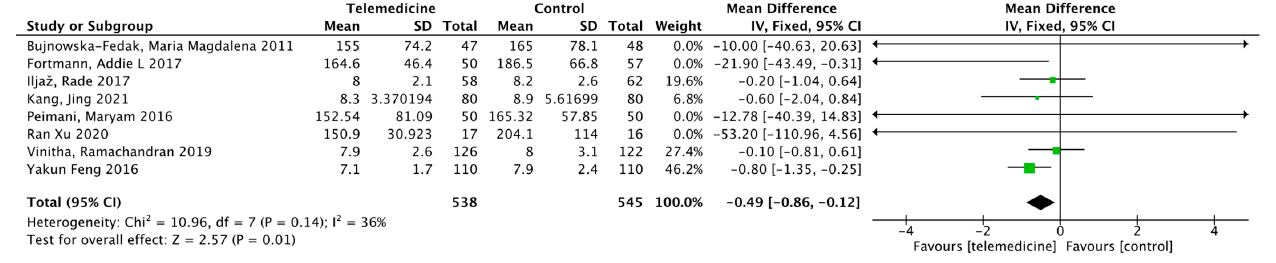
Figure 6. Mean difference in the changes in FBG levels for telemedicine and usual care interventions.